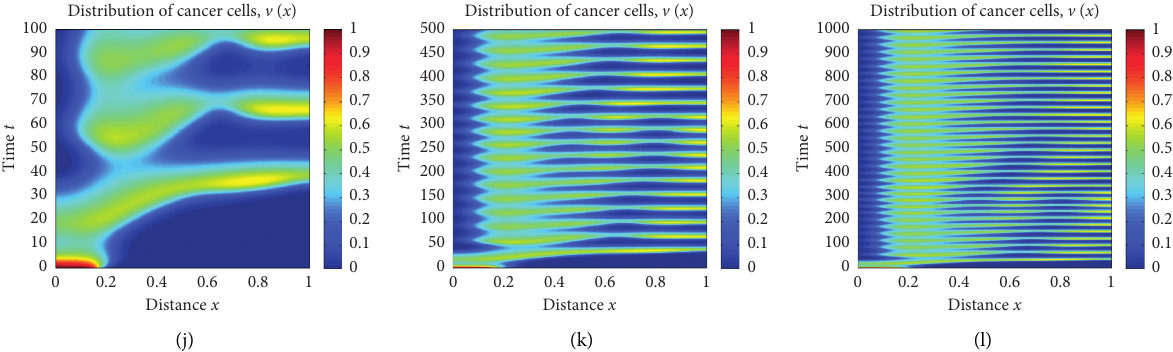
Figure 6: The spatial-temporal evolutions of the cancer cells’ diffusion coefficients for t � 100, t � 500, and t � 1000, where the antigenicity parameter is c � 0 . 25. The top row is for d � 0 . row is for d 2